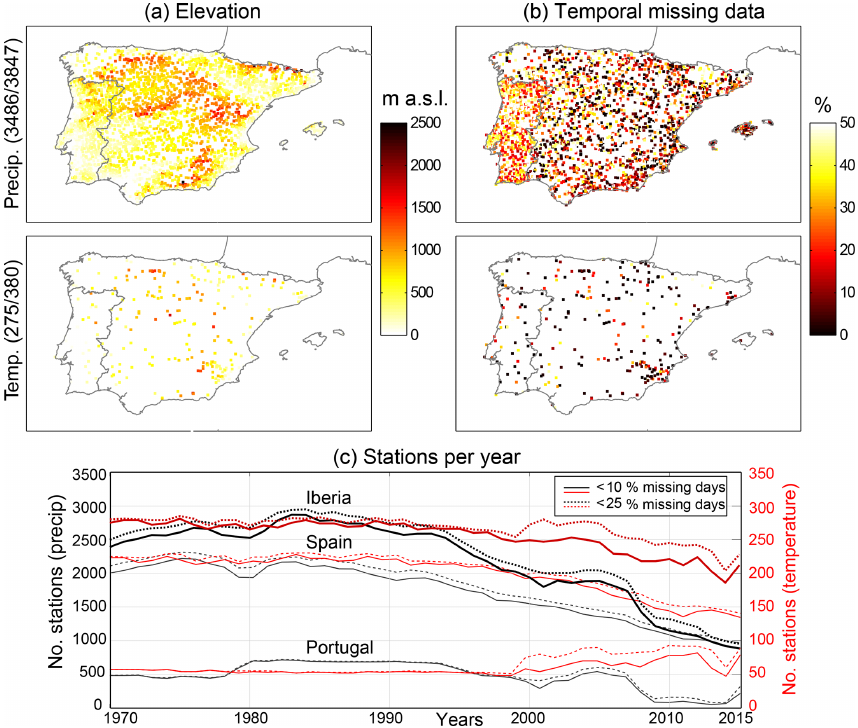
Figure 1. (a) Elevation and (b) data availability (percentage of missing days) in the period 1971–2015 for precipitation (top) and temperature (bottom) for the observational networks considered for the interpolation. The numbers on the left of the figure reflect the initial and final number of stations used, once the quality control is applied. (c) Number of stations – considering the Iberian Peninsula, Spain, or Portugal – per year for different thresholds of annual missing data for precipitation (black) and temperature